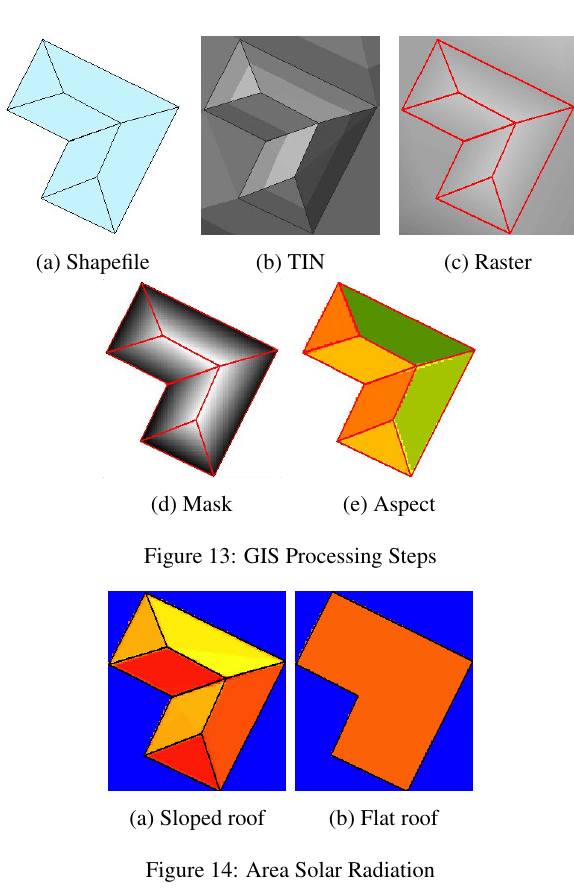
Figure 14: Area Solar